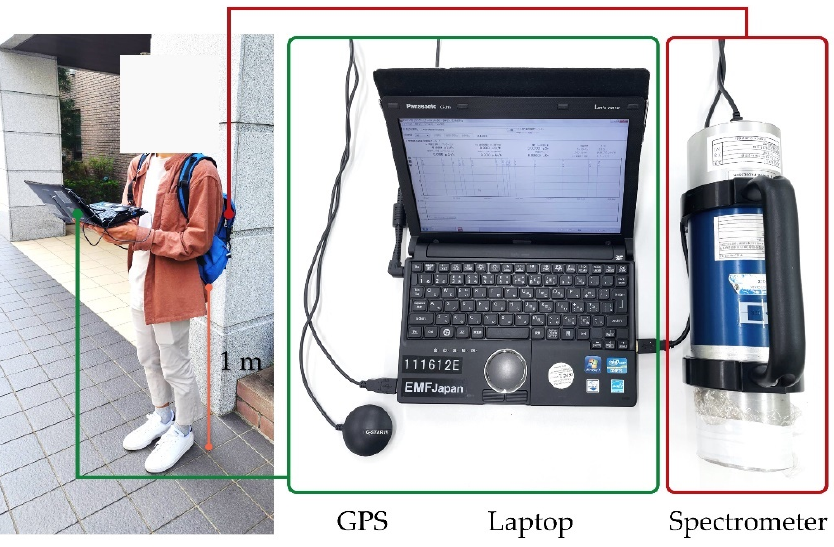
Figure 2. Walking survey system with the GPS and spectrometer carried in the backpack.